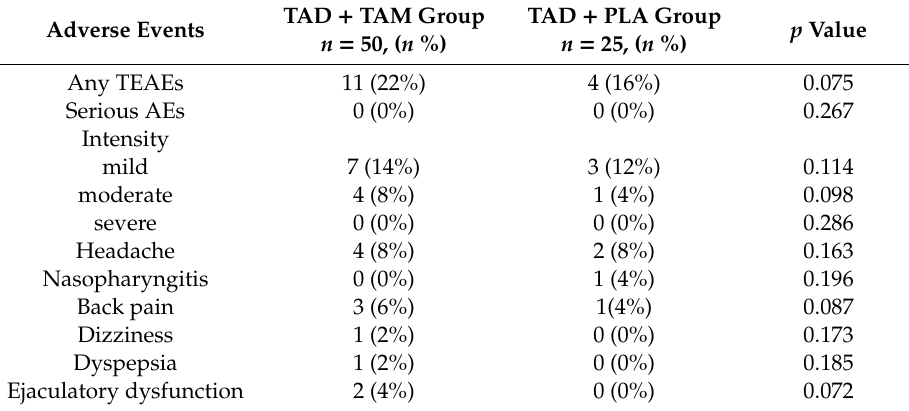
Table 3. Summary of adverse events at treatment period (12